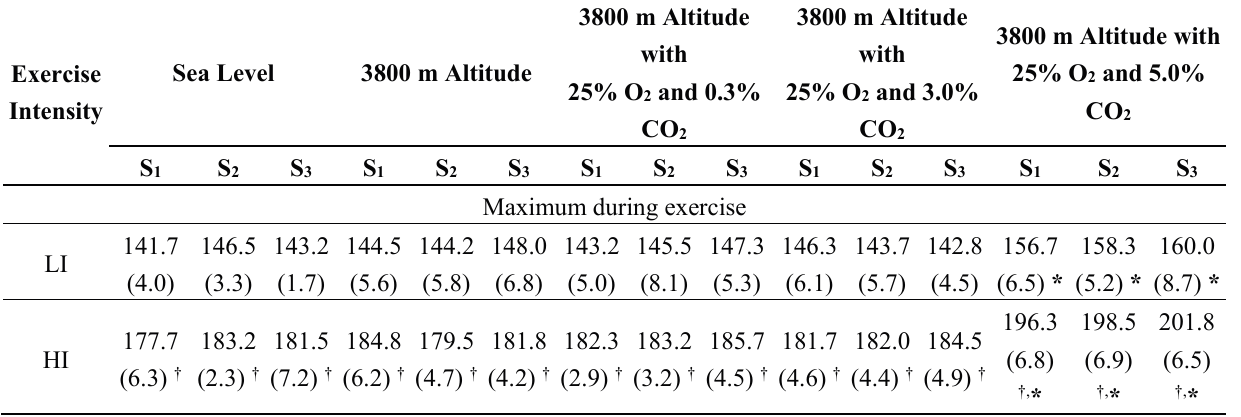
Table 4. Systolic blood pressure ((Mean (SD), mmHg) in exercise